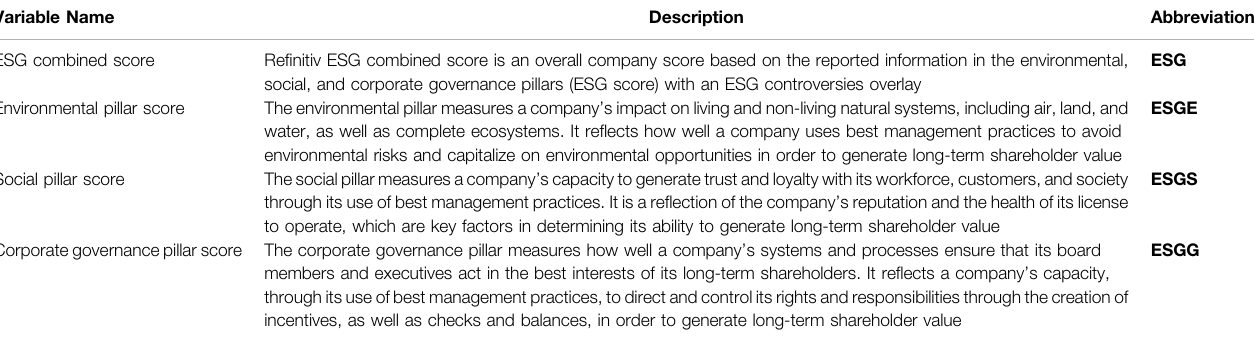
TABLE 3 | Description of ESG